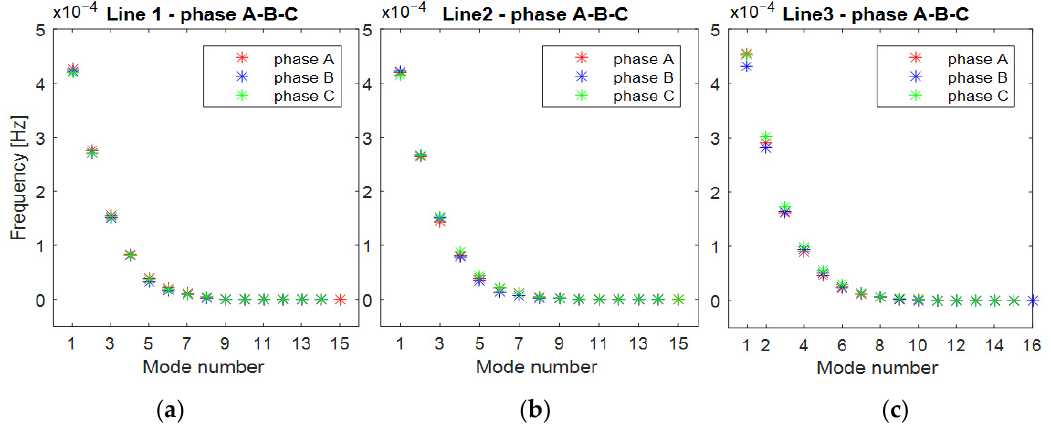
Figure 5. Hilbert ‐ Huang Transform (HHT) of the currents flowing in L1, L2, L3 for the whole period.